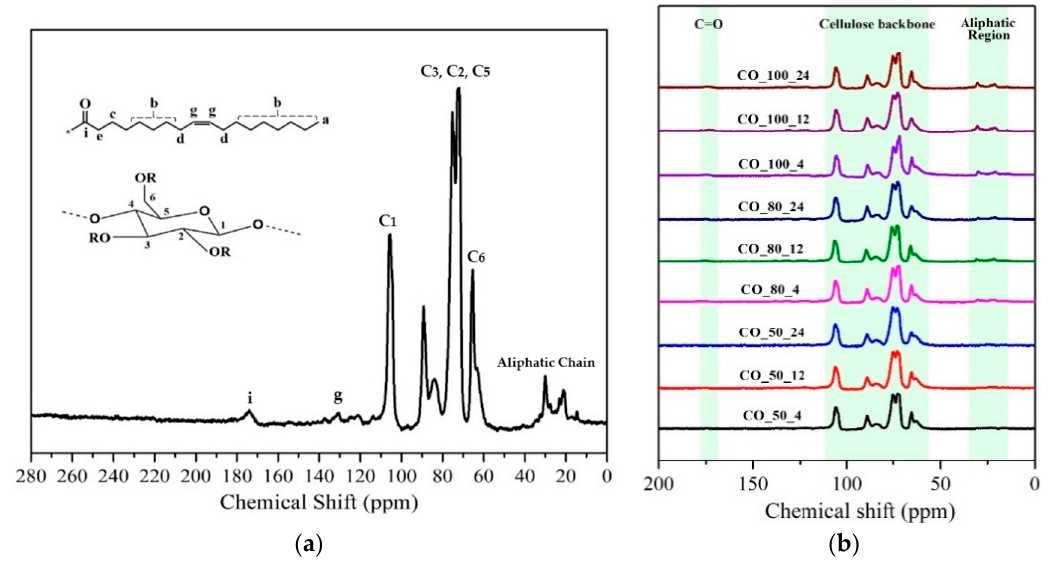
Figure 3. Solid state NMR (ssNMR) spectra of cellulose oleates ( a ) 100 °C and 24 h; ( b ) various reaction temperature and time.